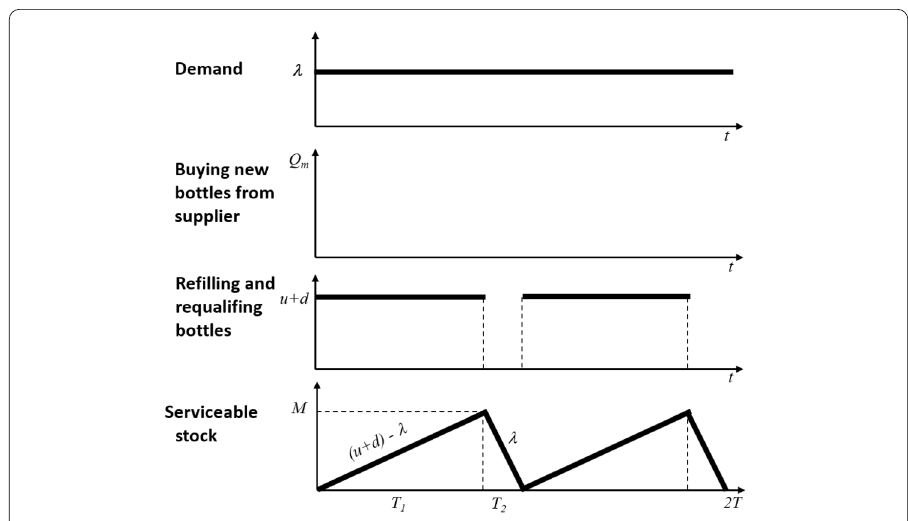
where M is the maximum stock level, and the batch size corresponds to the total produc- tion during period T 1 , i.e., Q = ( u + d ) T 1